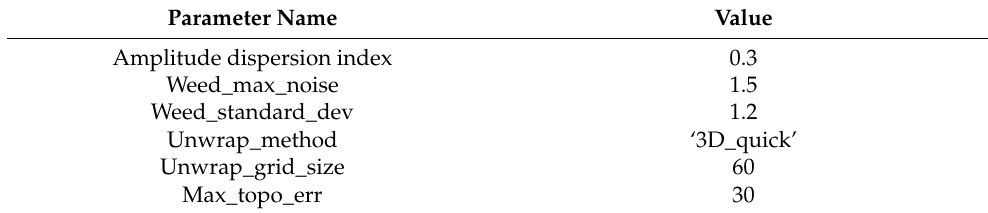
Table 2. Key parameter settings of